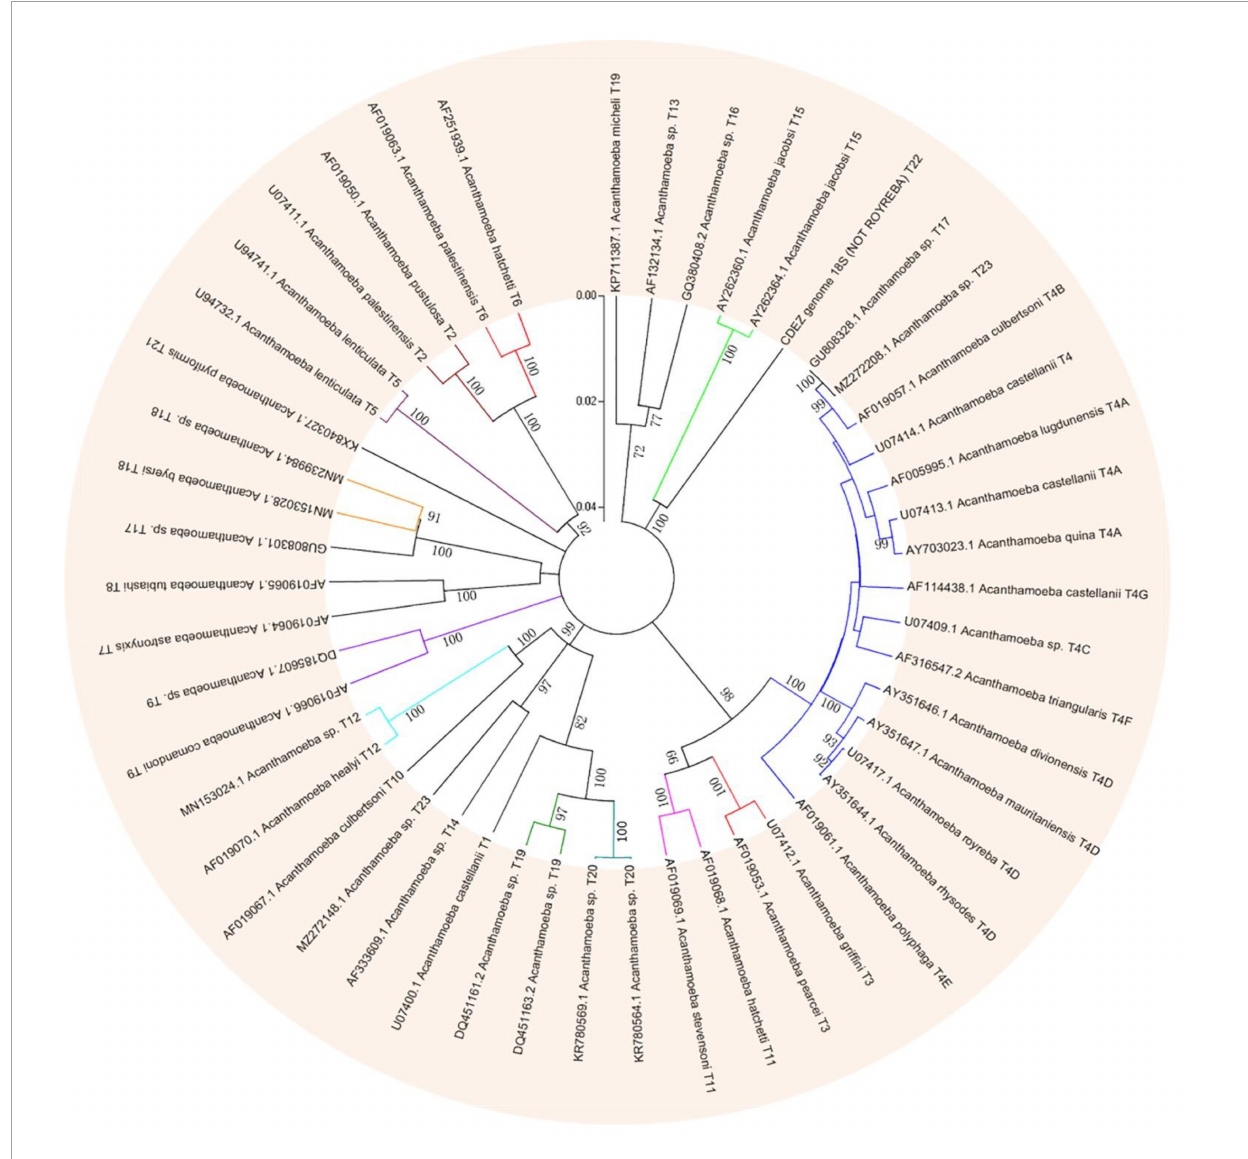
FIGURE3 Phylogenetic relationship of 49 various genotypes or subtypes of Acanthamoeba T1-T23 based on “complete” 18S rRNA gene sequence. The tree was constructed using the Neighbor-Joining algorithm in MEGA